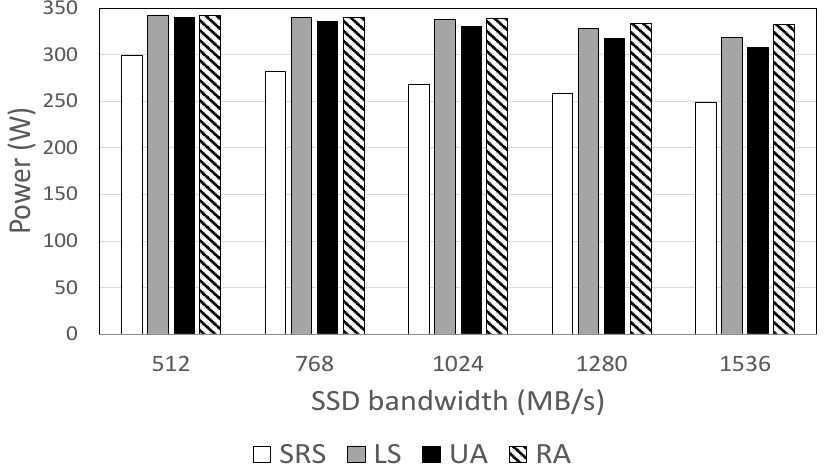
Figure 3. HDD power consumption against SSD